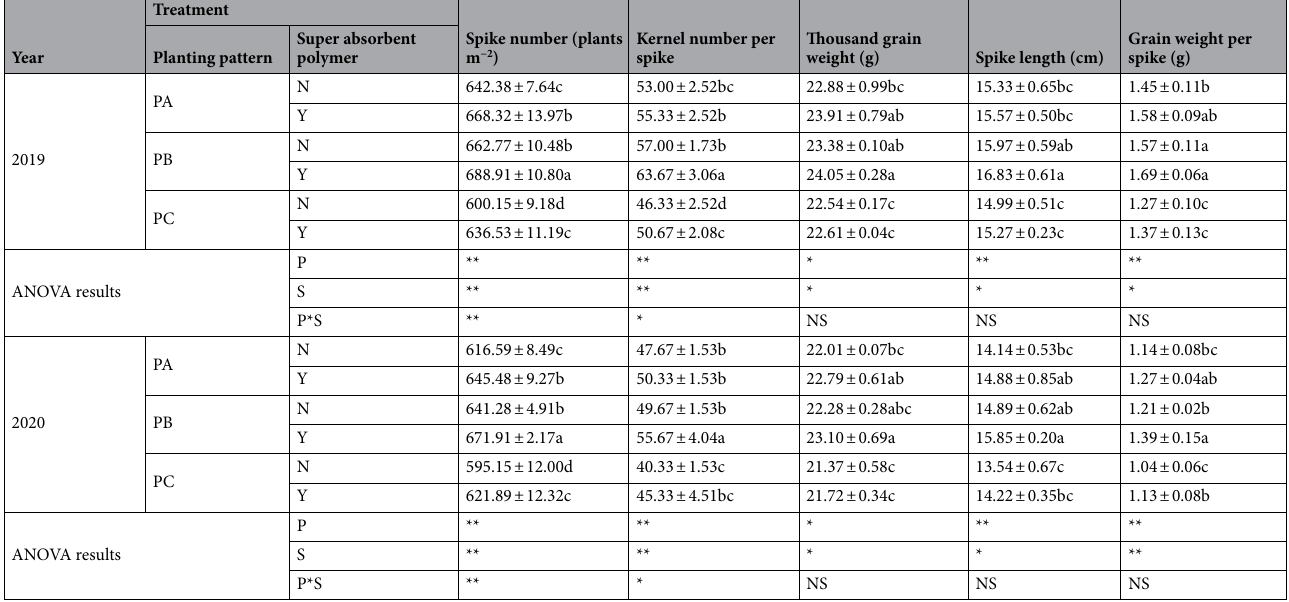
Table 5. Yield components as affected by planting patterns and super absorbent polymers in 2019–2020. Different letters of different treatments in the same year showed significant differences (P < 0.05), and the following numbers showed the standard deviation of the data. P and S represent planting pattern and super absorbent polymer.** significant at 0.01 level, * significant at 0.05 level, NS means no